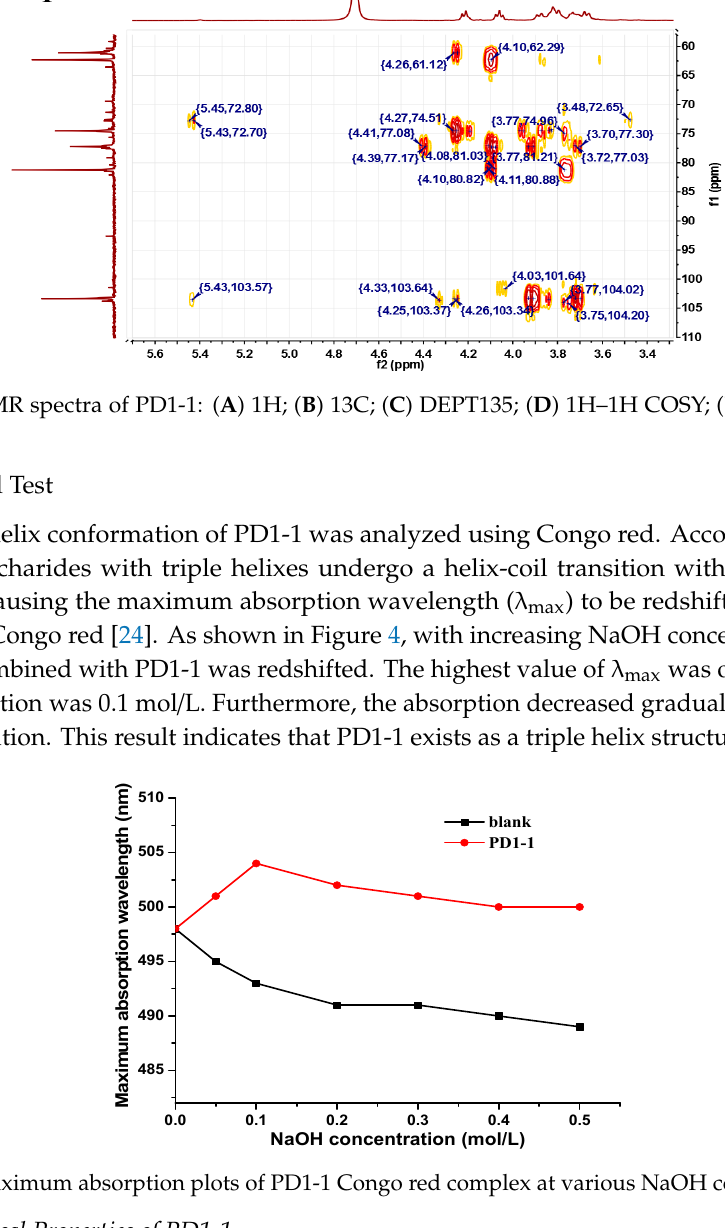
Table 3. Physicochemical properties of PD1-1.